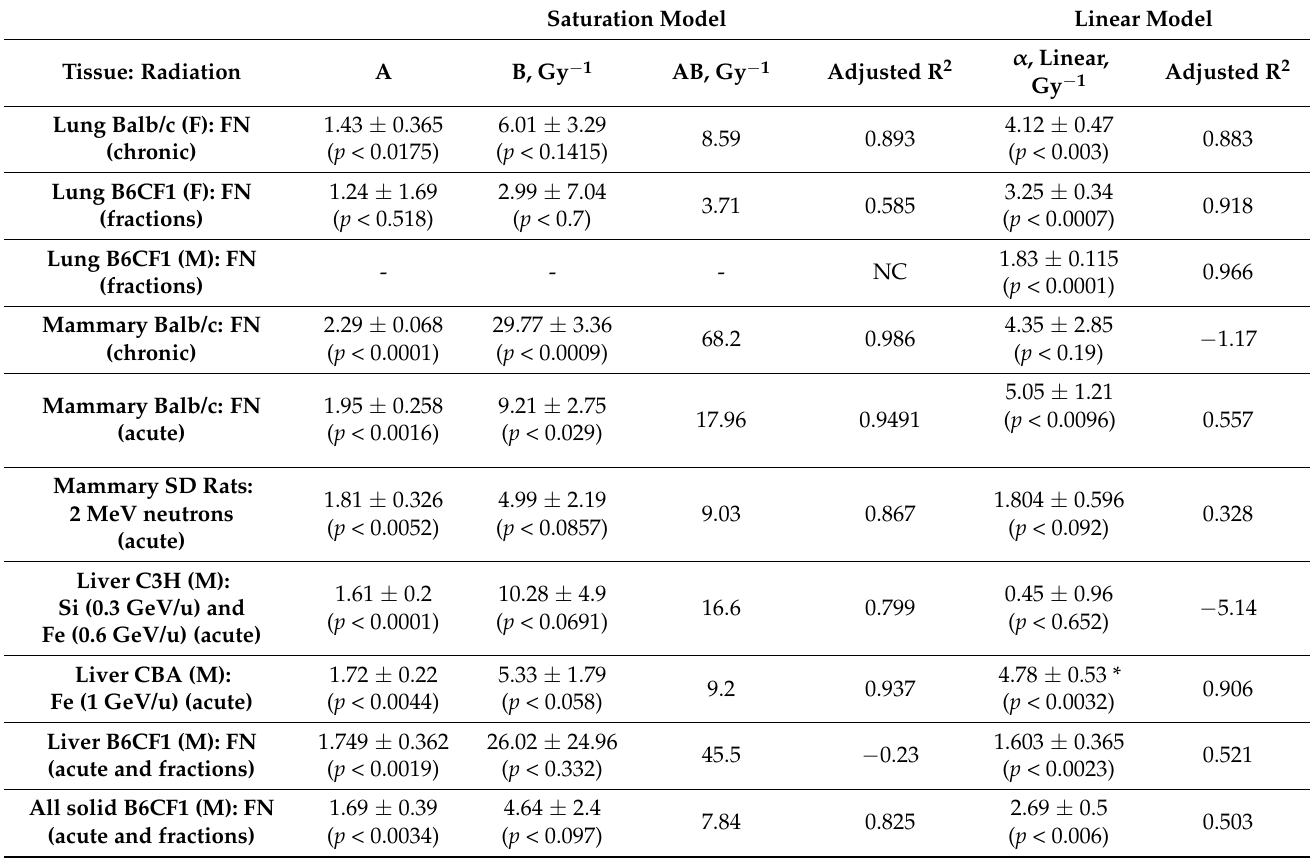
Table 3. Parameter estimations for the ERR function for several strains of mice or rats: lung and mammary tumors for females and liver tumors for